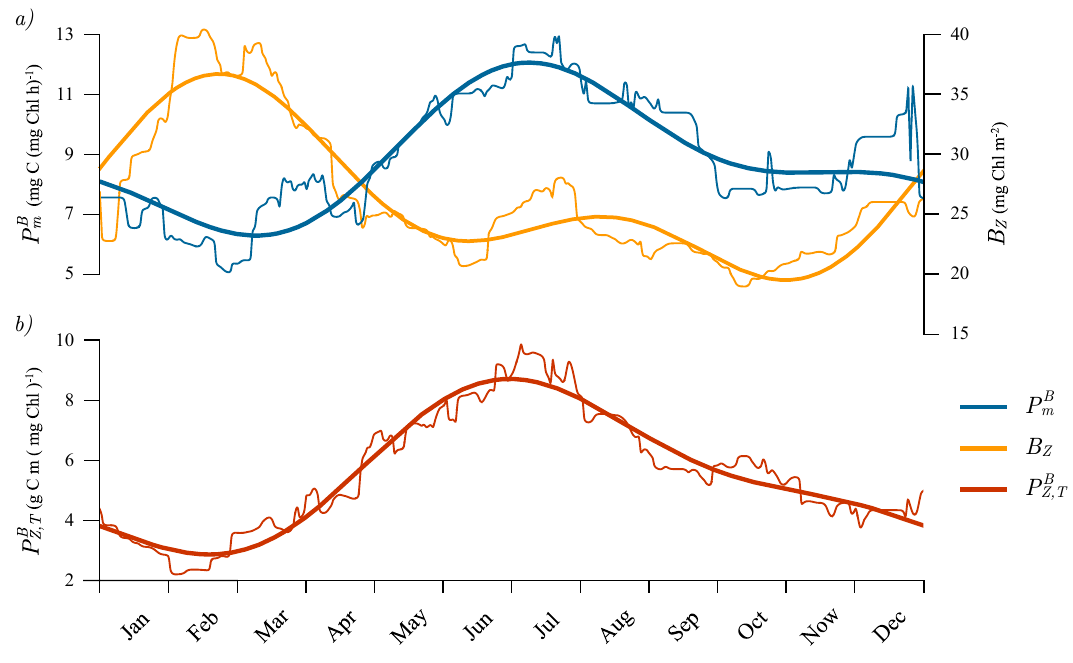
Figure 6. Estimated seasonal cycles for the BATS station. The thin curves represent the monthly averages on each Julian day, which were calculated from the daily values, 15 days prior and 15 days post a given Julian day. The thick curves are the fits of a sum of two sine functions (superimposed onto an annual mean) to the monthly averages. ( a ) Seasonal cycle of P B m (blue) and B Z (orange). ( b ) Seasonal cycle of P B (red). Z , T